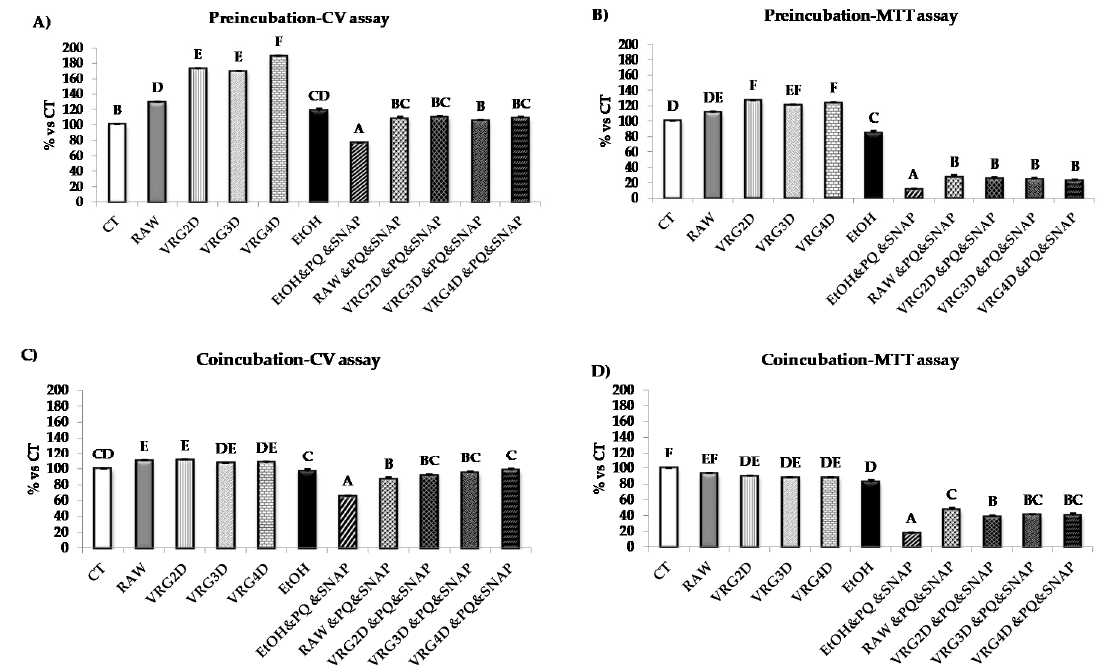
Figure 1. E ff ects of pre- or co-incubation with di ff erent mung bean extracts on viability and metabolic status of HT-29 cells treated or not with peroxynitrite. ( A ) preincubation crystal violet viability assay, ( B ) preincubation MTT metabolic status assay, ( C ) coincubation crystal violet viability assay, ( D ) coincubation MTT metabolic status assay. Results are represented as means ± SEM. Superscripts when di ff erent indicate p < 0.05. CT, control. RAW, raw Vigna radiata . VRG2D, 2d-germinated Vigna radiata.